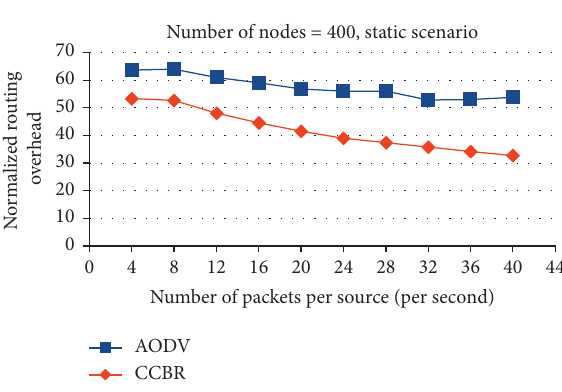
Figure 13: Normalized routing